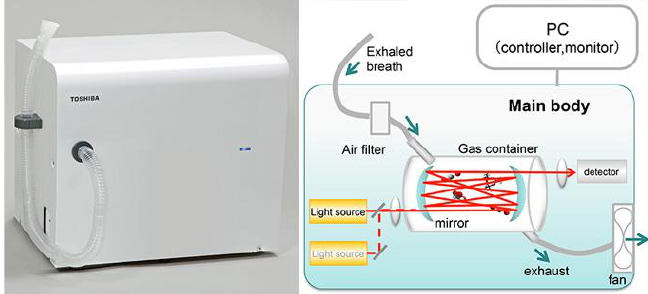
Figure 9. Toshiba developed a breathalyzer to determine health problems [107].